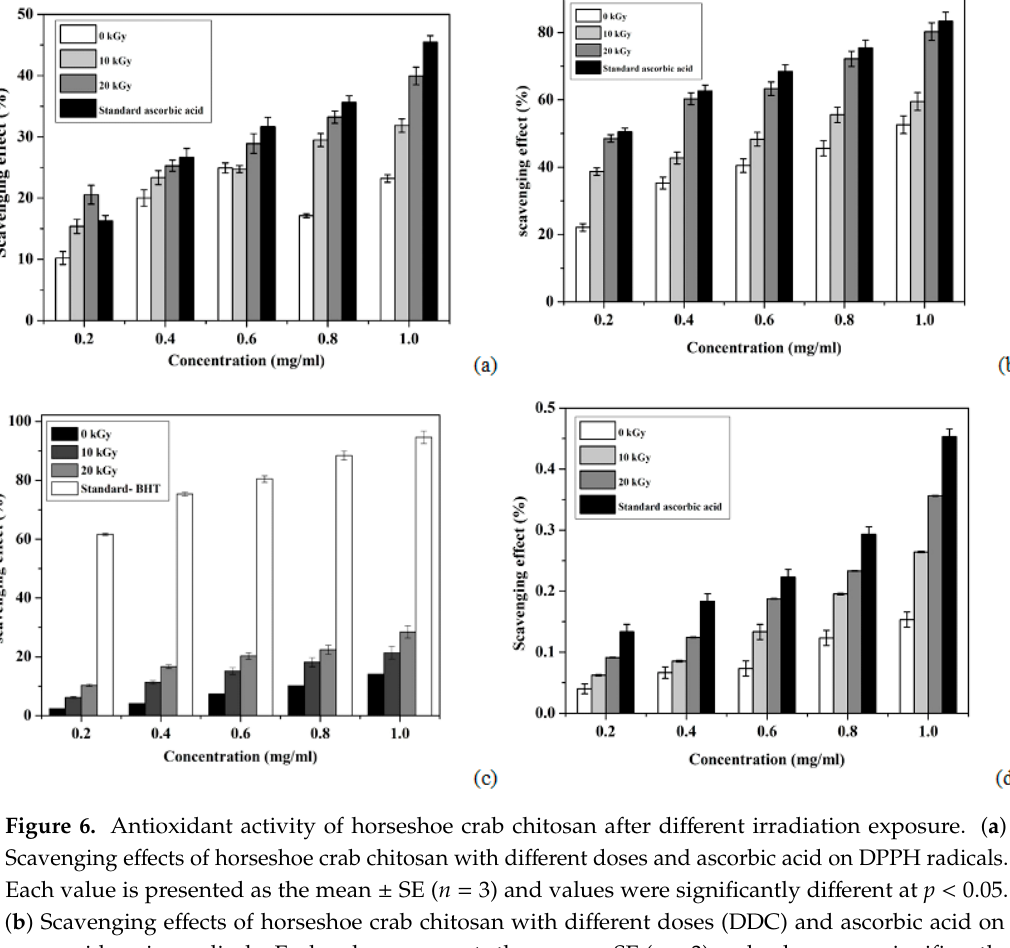
Figure 6. Antioxidant activity of horseshoe crab chitosan after different irradiation exposure. ( a ) Scavenging effects of horseshoe crab chitosan with different doses and ascorbic acid on DPPH radicals. Each value is presented as the mean ± SE ( n = 3) and values were significantly different at p < 0.05. ( b ) Scavenging effects of horseshoe crab chitosan with different doses (DDC) and ascorbic acid on superoxide anion radicals. Each value represents the mean ± SE ( n = 3) and values were significantly different at p < 0.05. ( c ) Chelating effects of horseshoe crab chitosan with different doses and EDTA on ferrous ions. Each value is presented as the mean ± SE ( n = 3) and values were significantly different at p < 0.05. ( d ) The total reducing power ability of Butylated hydroxytoluene and the different doses of chitosan from (DDC) horseshoe crab. Data are presented as the mean ± S.E. ( n = 3) and were significantly different at p < 0.05.